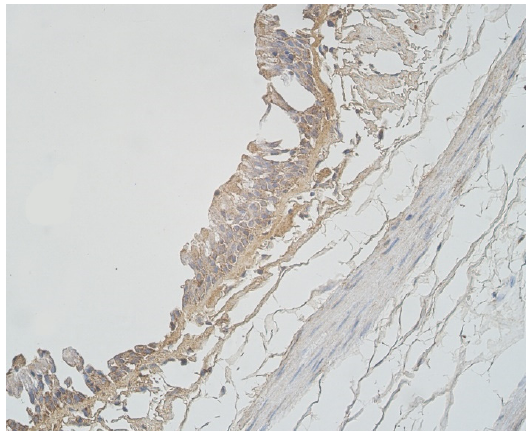
Figure 7. Immunohistochemical micrographs in lung tissue samples. ( a ) Few to moderate LL-37 immunoreactive cells in the alveolar epithelium and moderate to numerous LL-37 immunoreactive alveolar macrophages of 56-year-old male. LL-37 IMH, X200; ( b ) A few to moderate LL-37 positive structures in glands of 19-year-old male. LL-37 IMH, ×200.